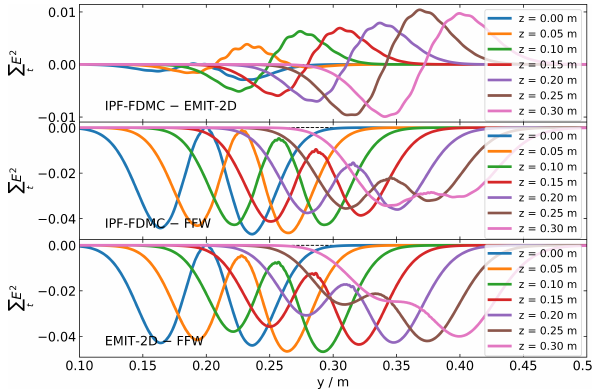
Figure 4. Di ff erence of the detector antenna signals obtained from the full-wave simulations for scenario #3.